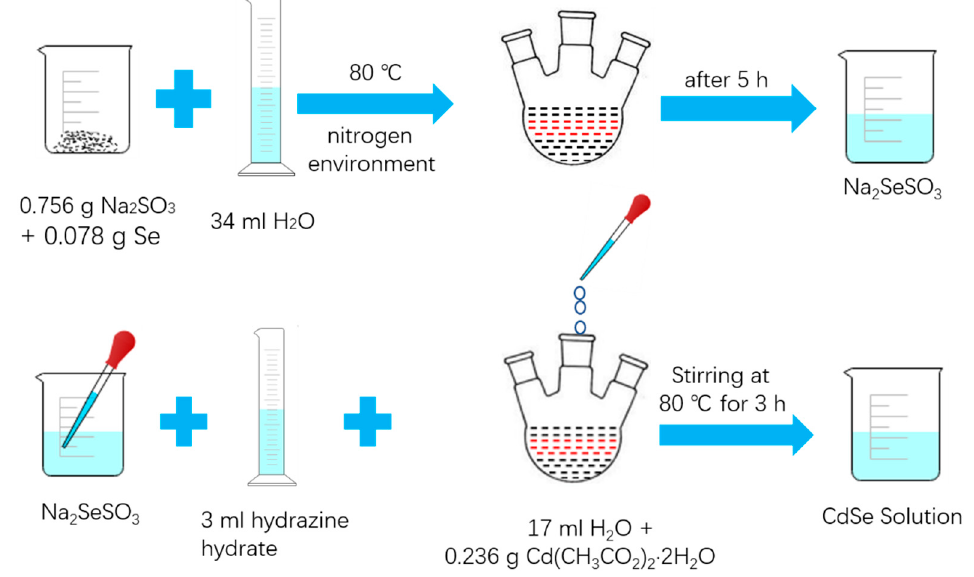
Figure 1. The schematic synthetic procedure of CdSe nanoparticles.